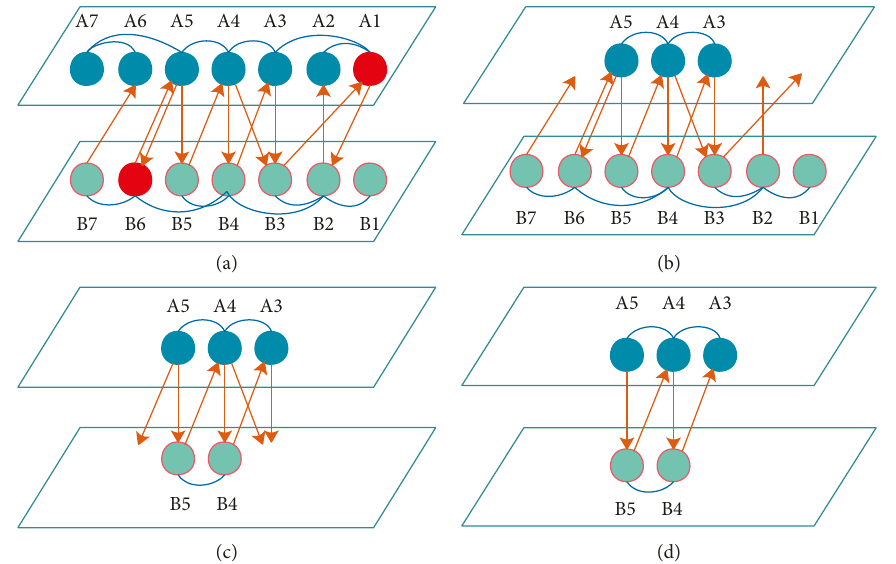
Figure 4: Network model for depicting the cascading failures on a two-layer network (networks A and B) with one-to-many correlations. The directed links are support links. The arrows point from the support nodes to the dependent nodes. (a) Nodes A1 and B6 are initially attacked. (b) Cascading failures on network A. Node A2 is removed because it is disconnected from network A. Node A7 is removed due to the lack of support. The removal of A7 further leads to the failure of node A6 as it is disconnected. (c) Cascading failures on network B. Nodes B1, B2, and B7 are removed as they have no supports. Node B3 is removed as it is disconnected from network B. (d) The LCC of the focal network in the final stable